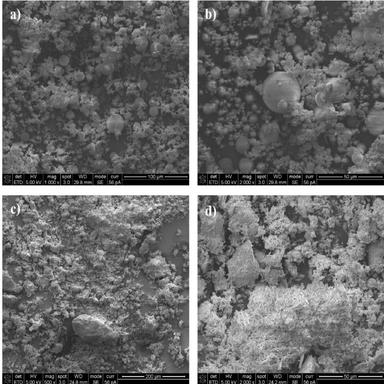
FESEM images obatined (a,b) fly ash and (c, d) marble waste.